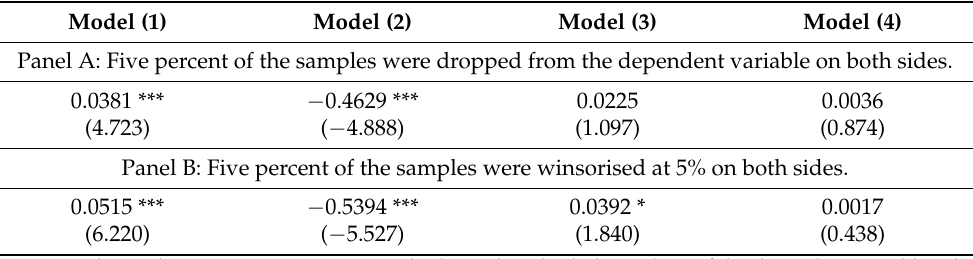
Table 13. Robustness test of LF on labour cost. Model (1) Model (2) Model (3) Model (4) Panel A: Five percent of the samples were dropped from the dependent variable on both sides. 0.0381 *** Panel B: Five percent of the samples were winsorised at 5% on both sides.